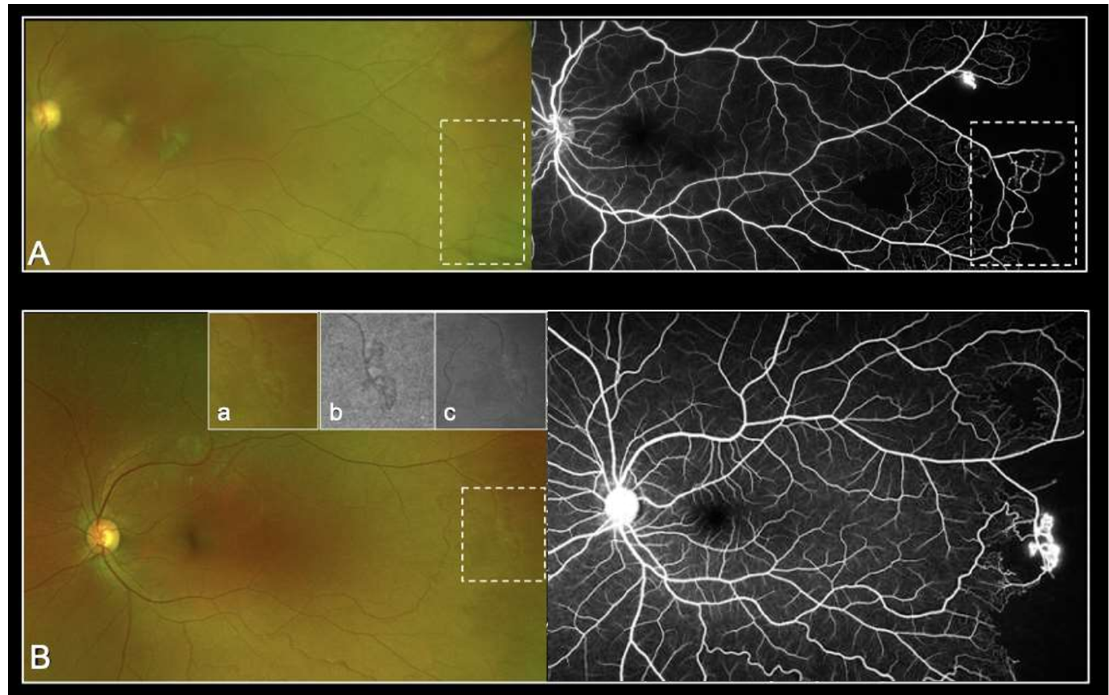
Figure 1. Representative UWF-imaging with peripheral arteriovenous anastomoses (stage 2 Goldberg) ( A ) and with sea fan lesion (stage 3 Goldberg) ( B ) clearly visible in color photography ( a ), red-free filter ( b ) and autofluorescence ( c ).